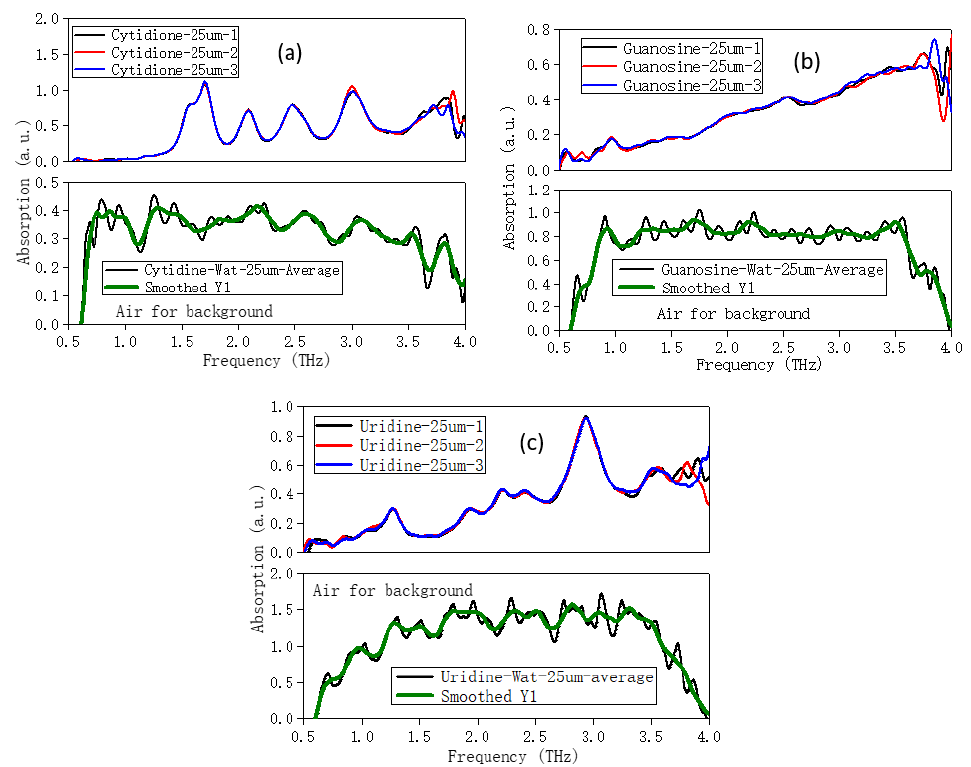
Figure 6. Comparison of THz spectra of solid and liquid samples—( a ) cytidine, ( b ) guanosine, Figure 7. Comparison of THz spectra of solid and liquid samples — ( a ) cytidine, ( b ) guanosine, ( c ) ( c ) uridine—with air for background. uridine — with air for background.